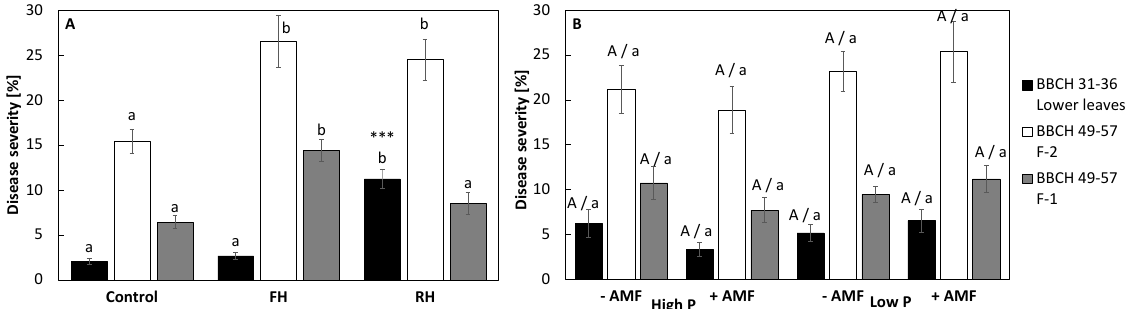
Fig. 2. Effect of experimental treatments on severity of net blotch ( Pyrenophora teres maculata) of barley in the pot experiment. A: Effects of hydrolysates (FH, chicken feather hydrolysate; RH, reference hydrolysate) averaged over the factors “P-level” and “AMF”. B: Effect of P-level and AMF averaged over the factor “hydrolysate”. Asterisks indicate a significant effect of hydrolysate at p < 0.001 (***) compared to the corresponding control according to Dunnett´s test. Different letters indicate statistically significant ( p < 0 .05) differences among treatments. B: Large letters indicate significant effect of AMF within given P-level, and small letters indicate significant effect of P-level within particular AMF-treatment. BBCH = growth stages according to Zadoks et al.